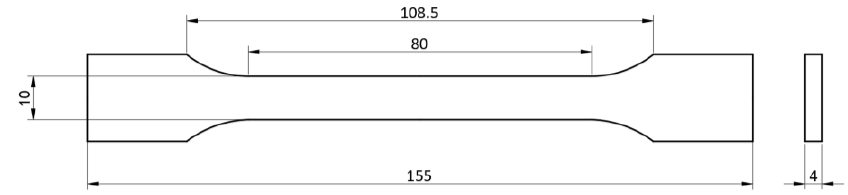
Figure 1. Dimensions of the specimen according to ISO 527.